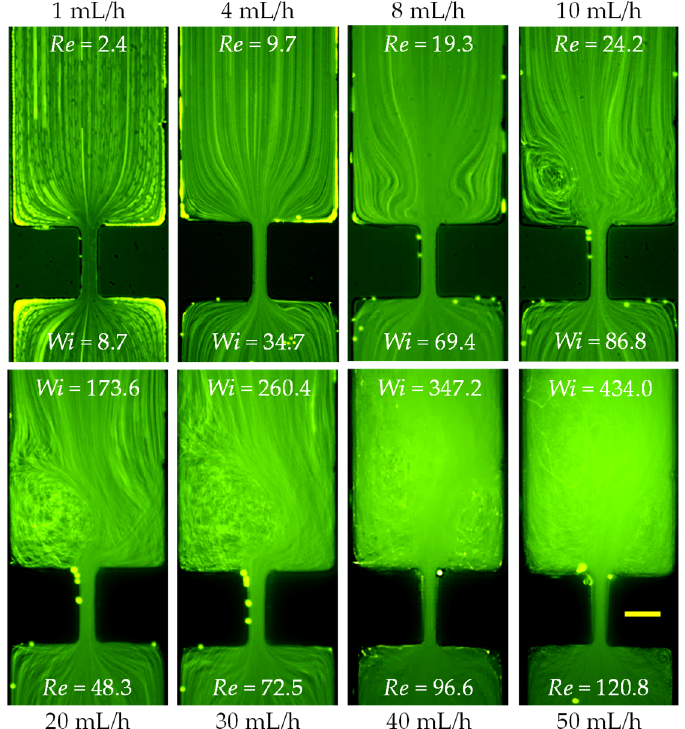
Figure 6. Inertial flow (downward) of 1000 ppm mildly elastic and weakly shear-thinning polyethylene oxide (PEO) solution at the contraction–expansion region of the microchannel. The scale bar represents 100 µm.